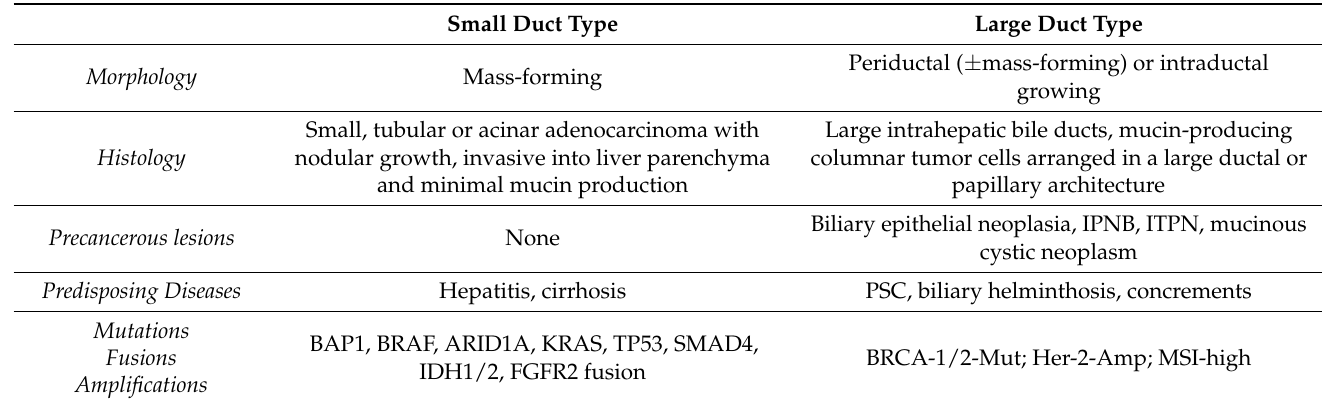
Table 1. Phenotypic classification of intrahepatic cholangiocarcinoma according to Banales et al.